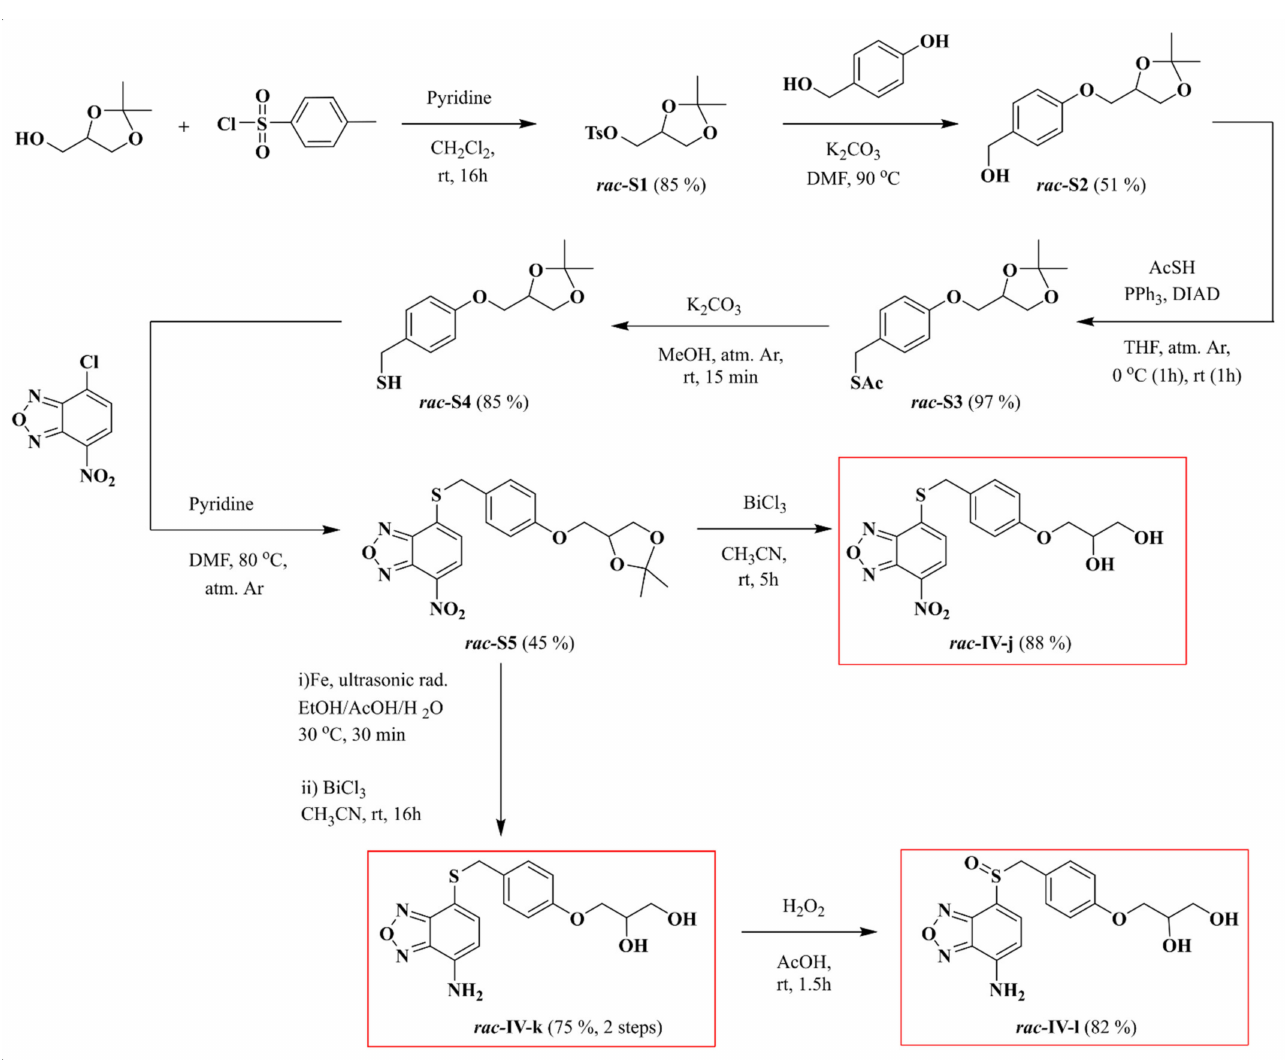
Figure 2. Scheme of the synthesis of compounds rac -IV-j , rac -IV-k and rac -IV-l